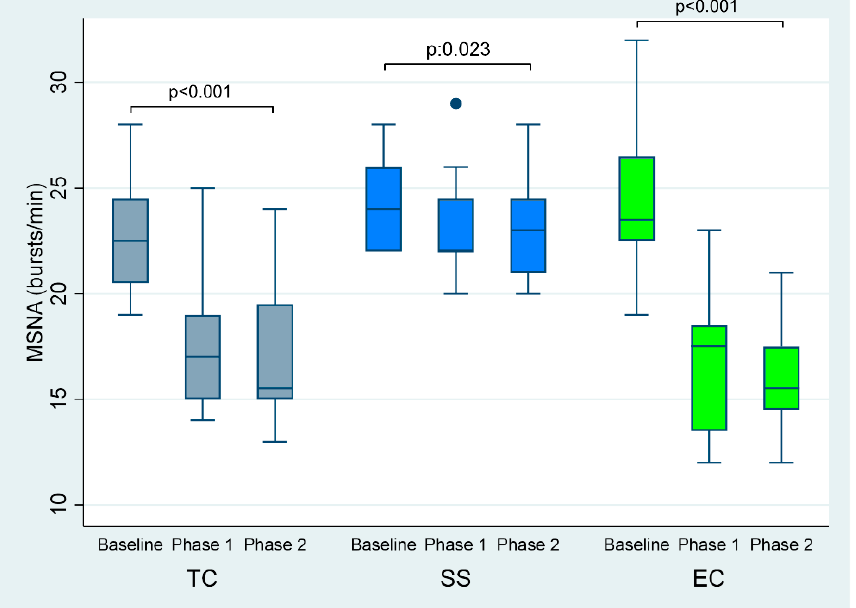
Figure 3. MSNA at baseline and phases 1 and 2 of TC, EC and sham smoking. EC, electronic cigarette; MSNA, muscle sympathetic nerve activity; TC, tobacco cigarette, SS, sham smoking.